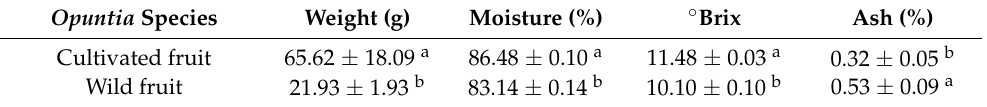
Table 2. Physico-chemical characteristics of cultivated and wild Opuntia fruits. Opuntia Species Weight (g) Moisture (%) ◦ Brix Ash (%) Cultivated fruit 65.62 ± 18.09 a Wild